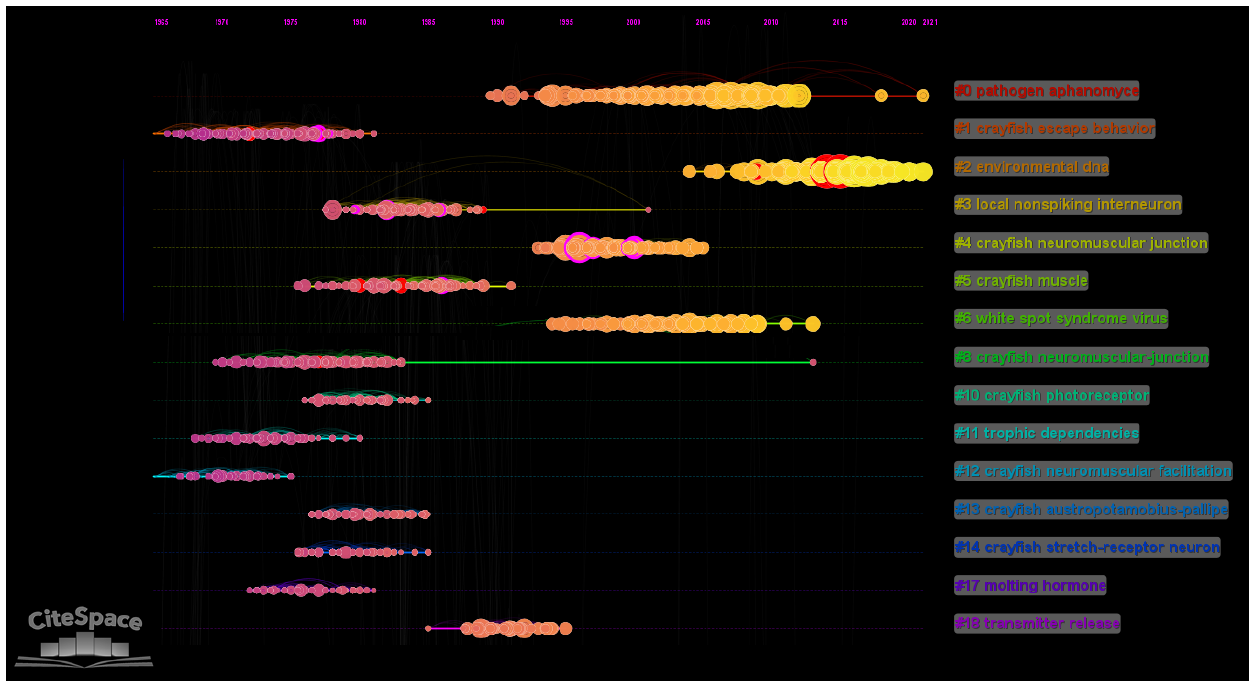
Figure 7. Summary of document cluster lifetimes (solid lines) from 1970 to 2021. The cluster labels were generated by CiteSpace. Table 8. Top 10 cluster IDs generated by CiteSpace.